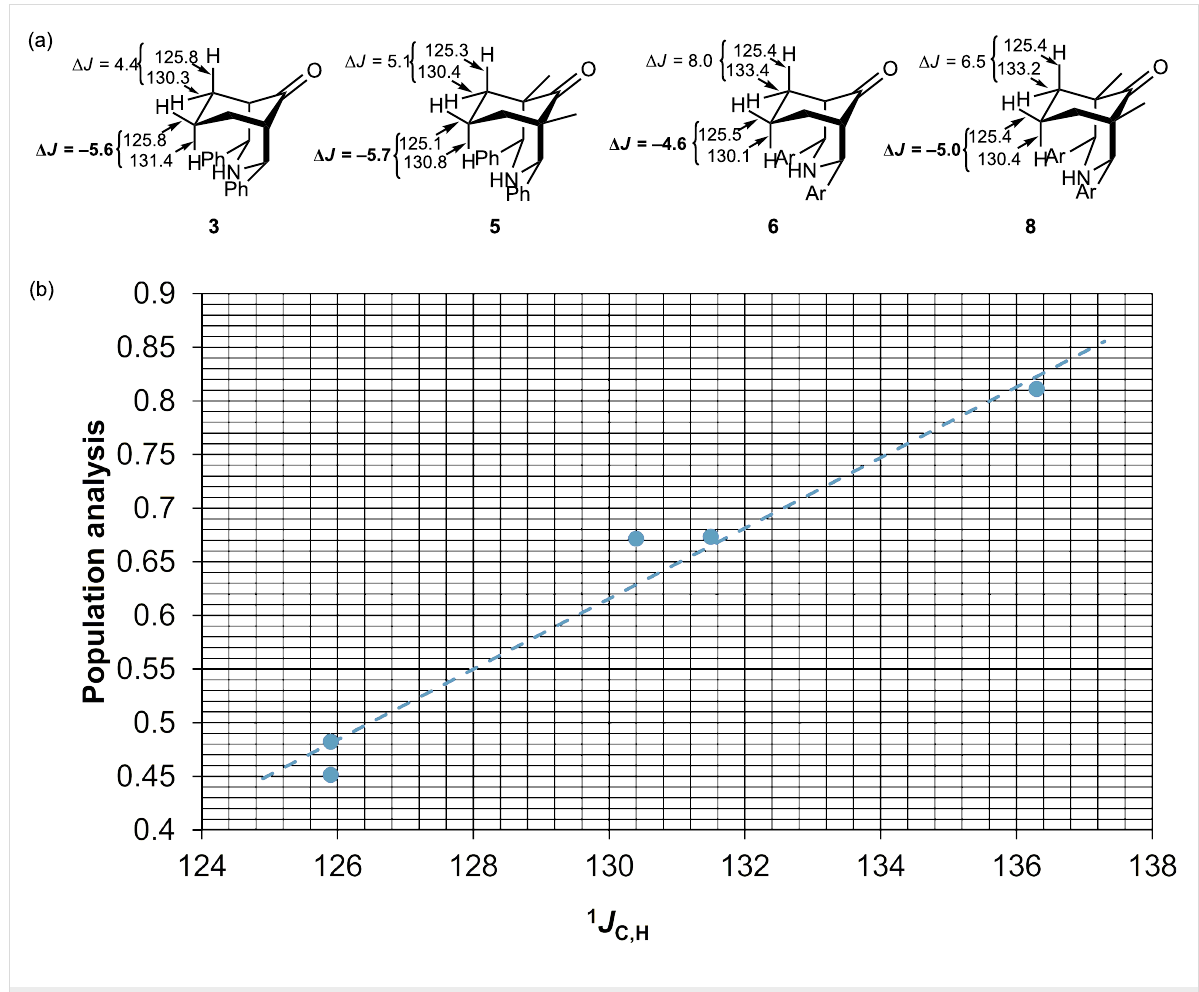
Figure 9: (a) 1 J C,H coupling constant of 3 , 5 , 6 , and 8 . (b) Plot of the population analysis versus 1 J C,H (slope = 0.0329 and R 2 = 0.9748).